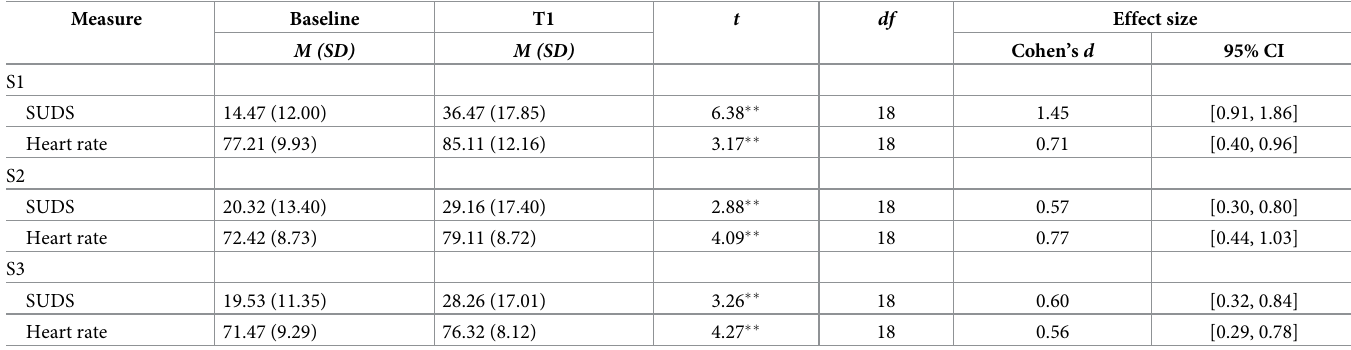
Table 2. Initial within-scenario Subjective Units of Discomfort Scale and heart rate